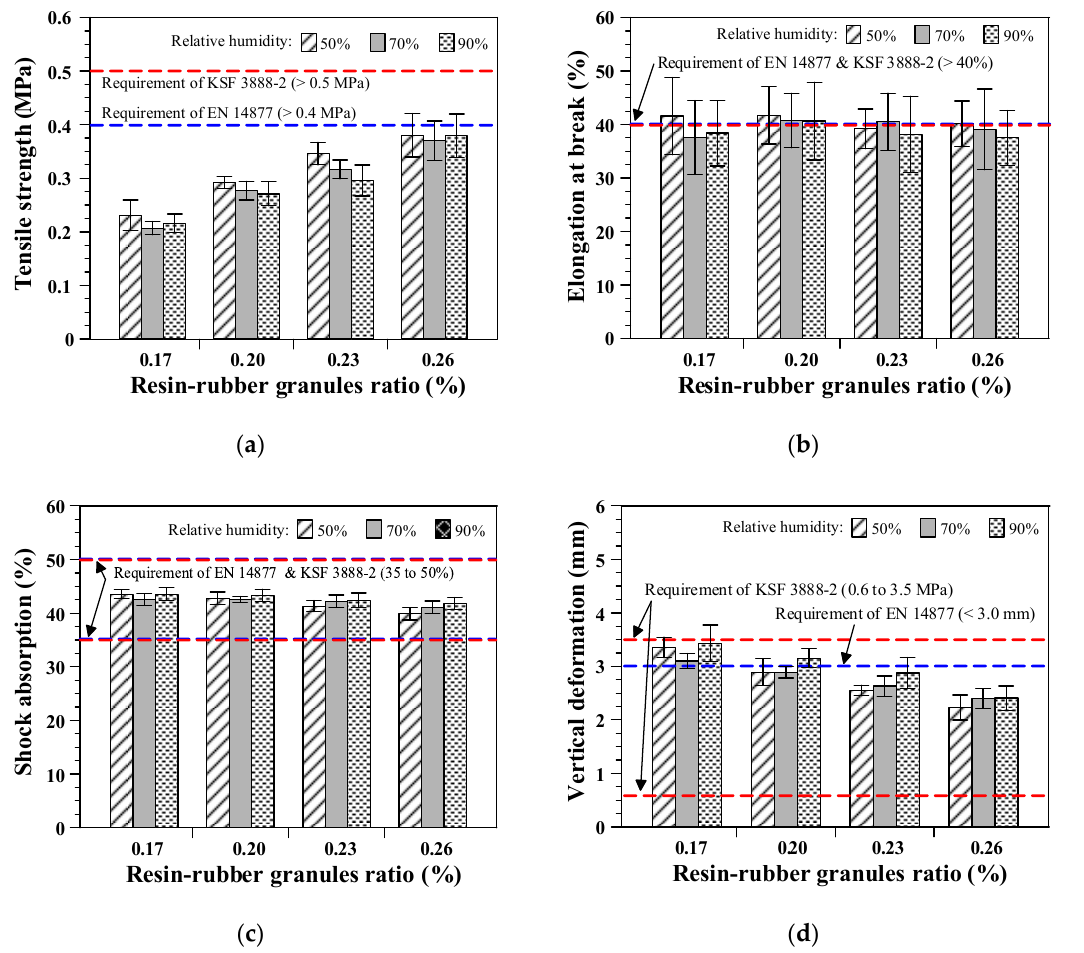
Figure 10. Effects of the relative humidity and resin–rubber granule ratio: ( a ) Tensile strength; ( b ) elongation at break; ( c ) shock absorption; and ( d ) vertical deformation.